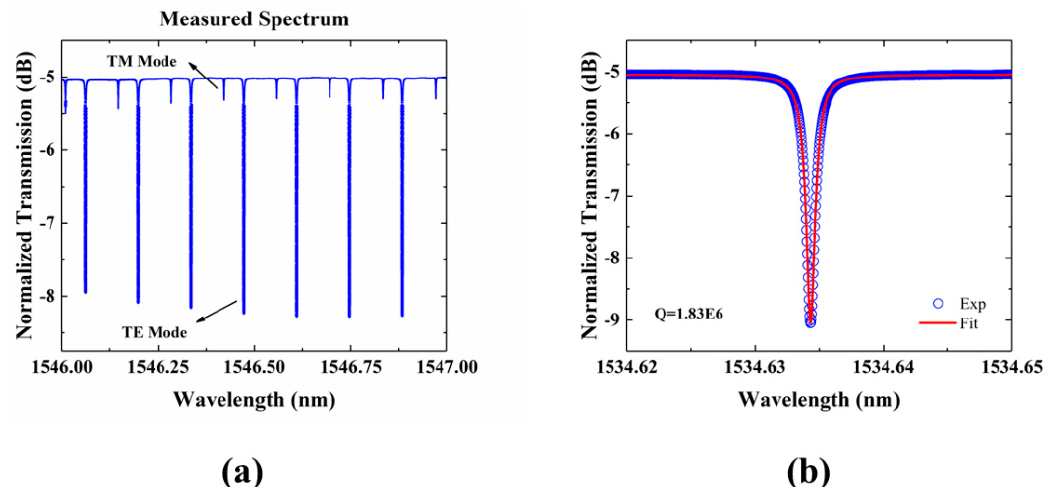
Figure 8. ( a ) Part of the measured transmission spectrum. ( b ) One peak of measured transmission spectrum with Lorentzian